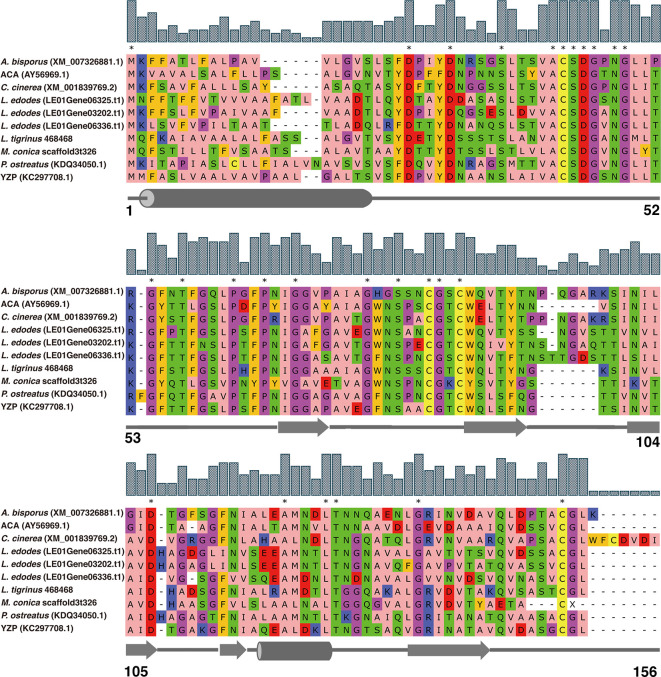
Amino acid sequence alignment of FIPs with cerato-platanin motif. The alignment was performed by MUSCLE. ACA and YZP were from A. camphorata and T. versicolor, respectively. Other FIP-like proteins, A. bisporus, L. edodes, L. tigrinus, C. cinerea, P. ostreatus, and M. conica SH, were selected by genome mining using the sequences of ACA and YZP as baits. NCBI accession numbers are addressed in brackets. Amino acids residues are colored according to their physicochemical properties, alphatic/hydrophobic (residues ILVAM) - rose; aromatic (FWY) - orange; positive (KRH) - dark blue; negative (DE) - red; hydrophilic (STNQ) - light green; conformationally special (PG) - magenta; cysteine (C) - yellow. Bar above amino acids residues represent consensus level, and consensus amino acid residues were labeled by asterisk. Secondary structure predictions are shown under the sequences, cylinders represent α helices, arrows represent β sheets, and straight lines represent random coils. Amino acid residue positions are numbered in last row.